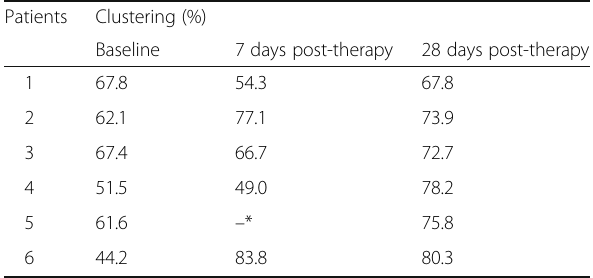
Table 4 Clustering (%) represents the degree of voxel clustering for all lesions, for the three time points: baseline, 7 days post- therapy and 28 days post-therapy. Voxels are more clustered when the percentage is closer to 100% Patients Clustering